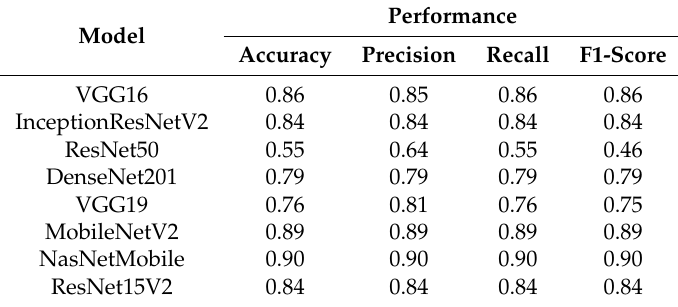
Table 3. Overall model’s performance on CT scan test